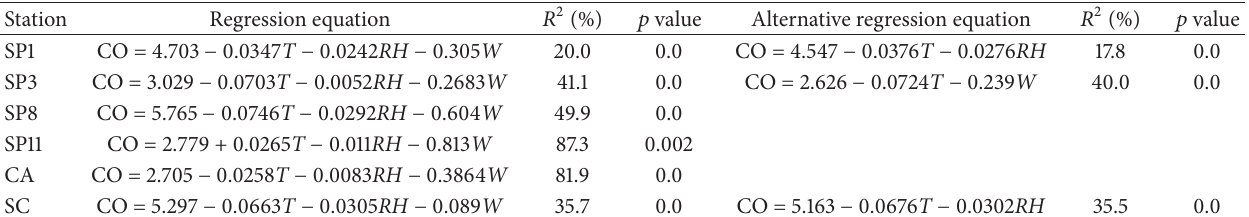
Table 4: Regression equation for CO concentration (CO), temperature ( 𝑇 ), relative humidity ( 𝑅𝐻 ), and wind speed ( 𝑊 ). 𝑅 2 and 𝑝 value refer to the regression equation. An alternative regression equation is calculated when a variable coefficient does not have a 95% confidence